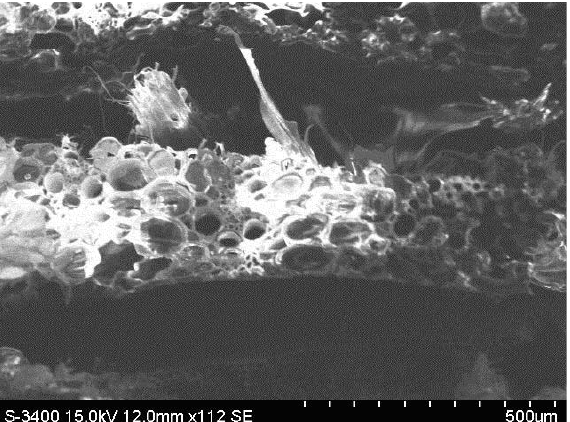
Figure 15. The image of the breaking section of a representative sample of wheat straw-reinforced composite material.